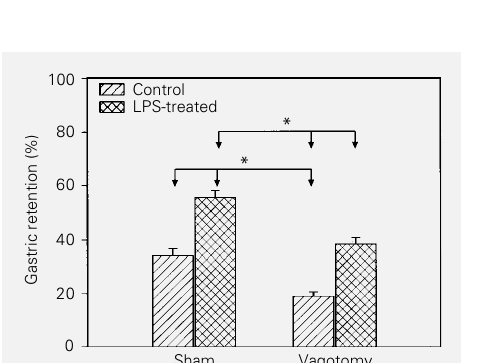
Figure 1 - Effect of E. coli lipo- polysaccharide on gastric reten- tion of 0.9% NaCl by rats. A, Gastric retention was evaluated 5 h after the iv administration of different LPS doses. B, Gastric retention was determined 0.5, 2, 5, 8 and 24 h after iv adminis- tration of 50 (cid:181)g/kg LPS. Control groups received vehicle instead of endotoxin. Data are reported as means – SEM for 8 animals (panel A) or 6 animals (panel B) in each subgroup. *P<0.05 com- pared to control group (Tukey test). r = 0.97 for dose-response correlation. + P<0.05 compared to control group (Tukey test).